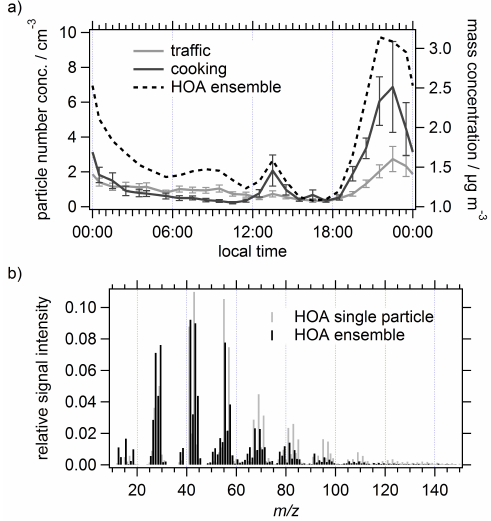
Fig. 5. (a) Average diurnal cycles of number concentrations of par- ticles classified as cooking and traffic (left axis), and of the mass concentration of the HOA factor (right axis) retrieved via positive matrix factorization of ensemble organic mass spectra (Freutel et al., 2013). Error bars represent the standard deviations of the aver- ages; error bars for HOA ensemble (relative uncertainty of 20% from PMF analysis; Freutel et al., 2013) are omitted for clarity. (b) Comparison of HOA ensemble mass spectrum with the aver- age HOA single-particle mass spectrum (average mass spectrum of all single-particle mass spectra classified as cooking or